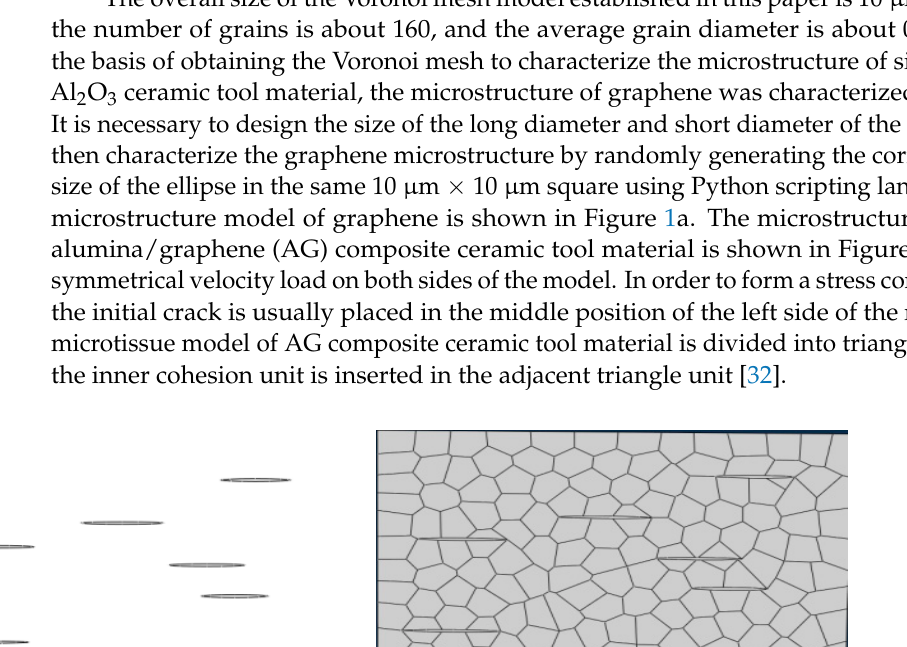
Table 1. The cohesive parameters of the microstructure model of alumina/graphene composite ce- ramics (AG) [32].